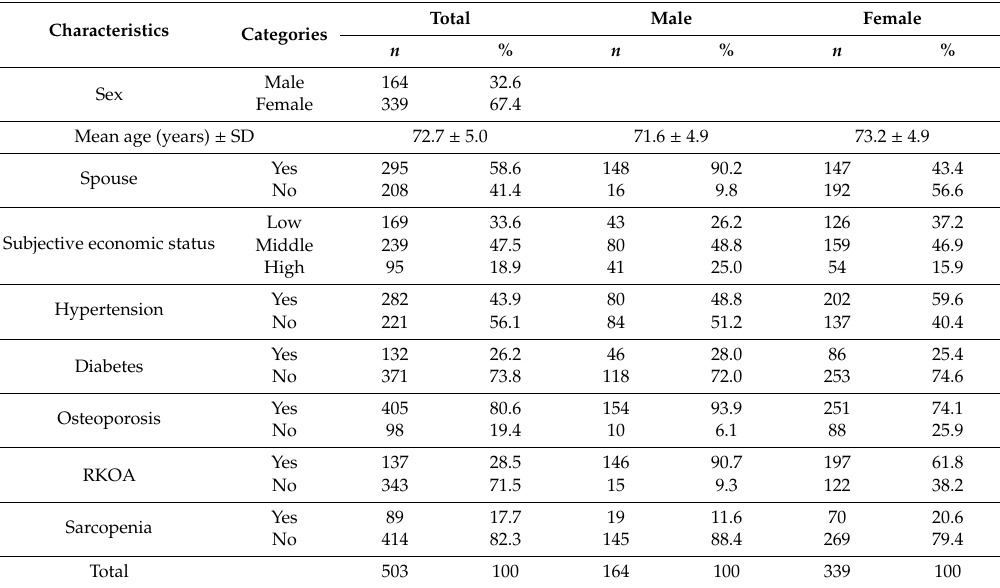
Table 1. Subject characteristics by sex ( n =